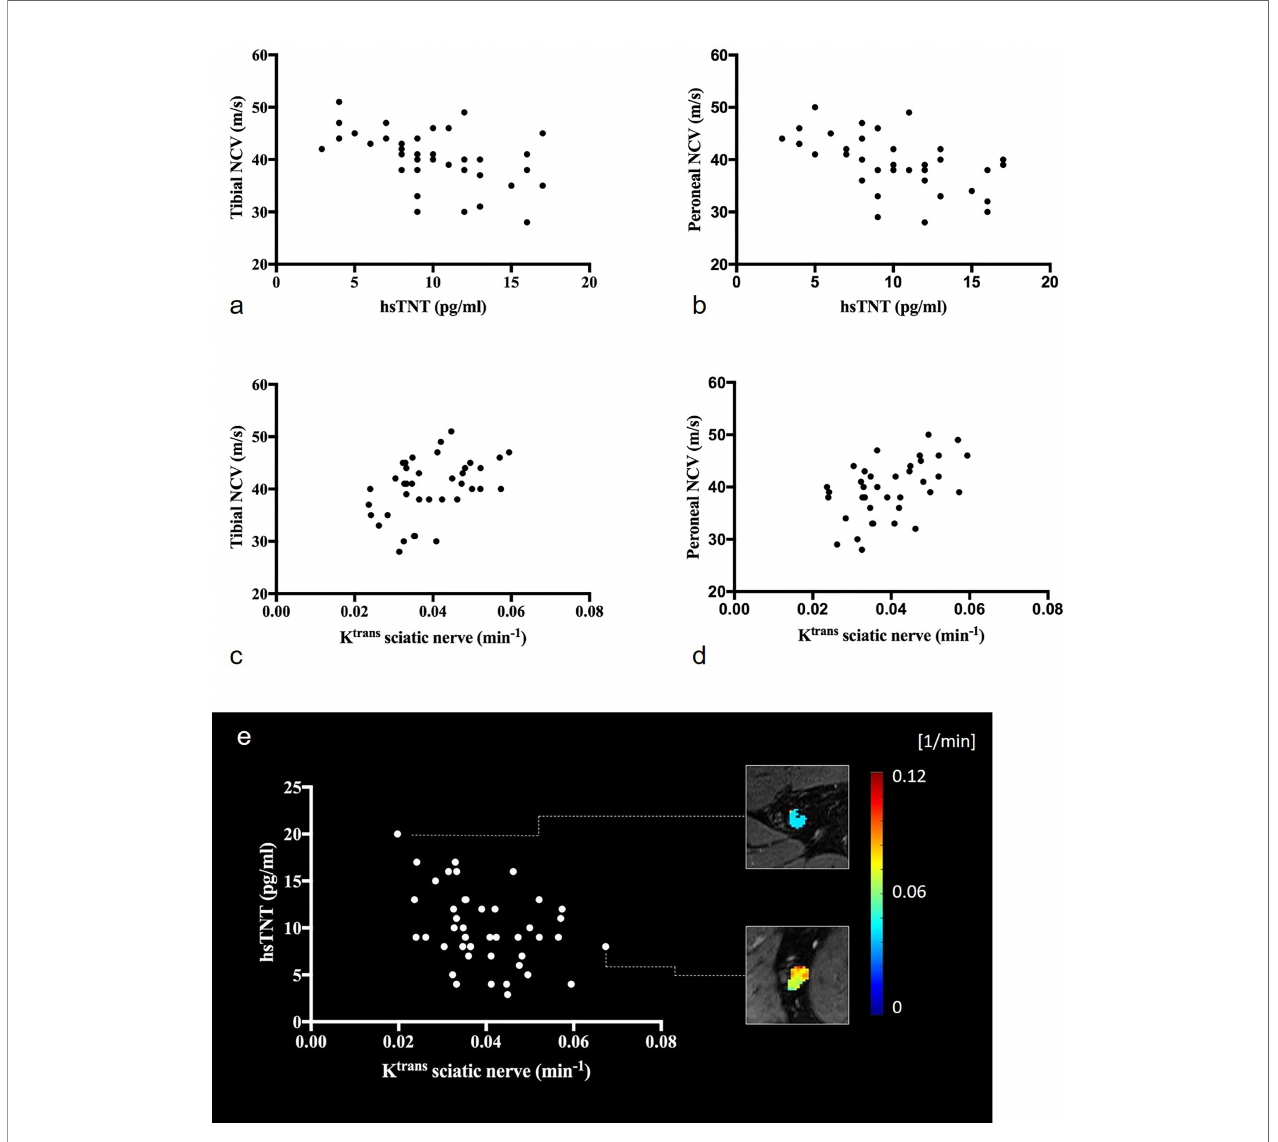
FIGURE 2 | Correlations of the sciatic nerve ’ s K trans and hsTNT with electrophysiologic parameters: (A) correlation of hsTNT with tibial nerve conduction velocities (r=-0.51; p=0.001), (B) correlation of hsTNT and peroneal nerve conduction velocities (r=-0.53; p=0.001), (C) correlation of K trans with tibial nerve conduction velocities (r=0.42; p=0.008), (D) correlation of K trans and peroneal nerve conduction velocities (r=0.49; p=0.002), (E) illustration of the correlation between K trans and hsTNT (r=-0.38; p=0.012). Representative color-coded K trans maps of the sciatic nerve are shown. Upper rectangle: T2D patient with hsTNT levels of 20pg/ml and a sciatic nerve ’ s K trans of 0.020 (min -1 ), lower rectangle: T2D patient with hsTNT levels of 8pg/ml and a sciatic nerve ’ s K trans of 0.067 (min -1